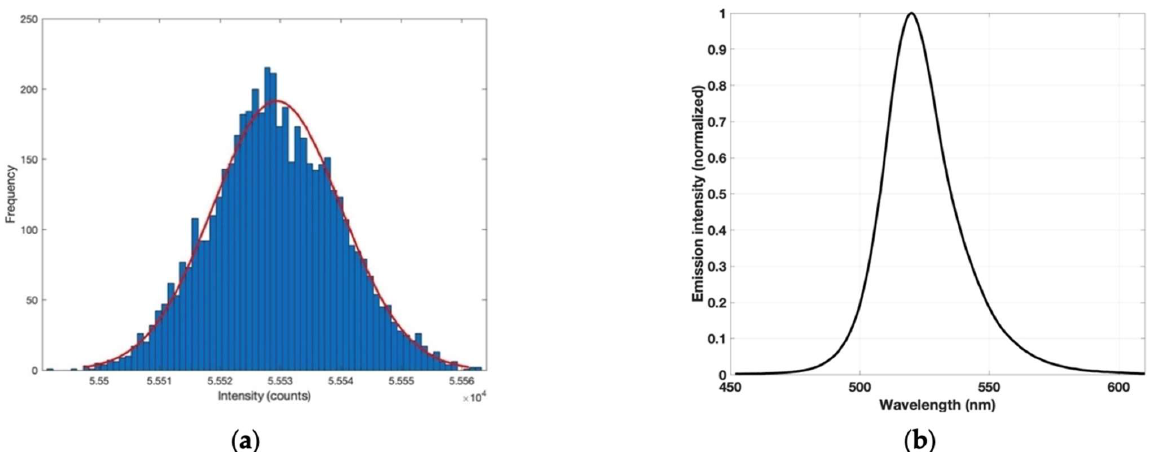
Figure 8. ( a ) Normal error curve distribution for green channel of diode, 5000 measurements (blue bars), and best fit of distribution (red line); ( b ) spectral energy distribution of RGB LED green channel with a peak at 520 nm.